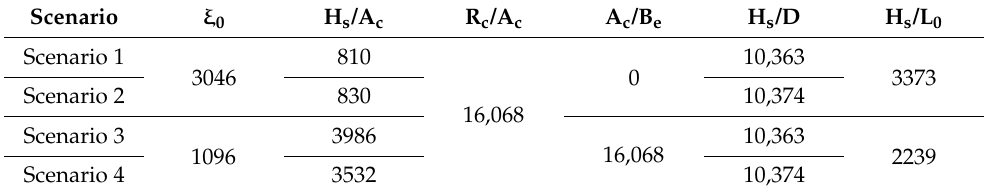
Table 12. Number of cases valid for the formula validity parameters for Nørgaard et al. (2013).